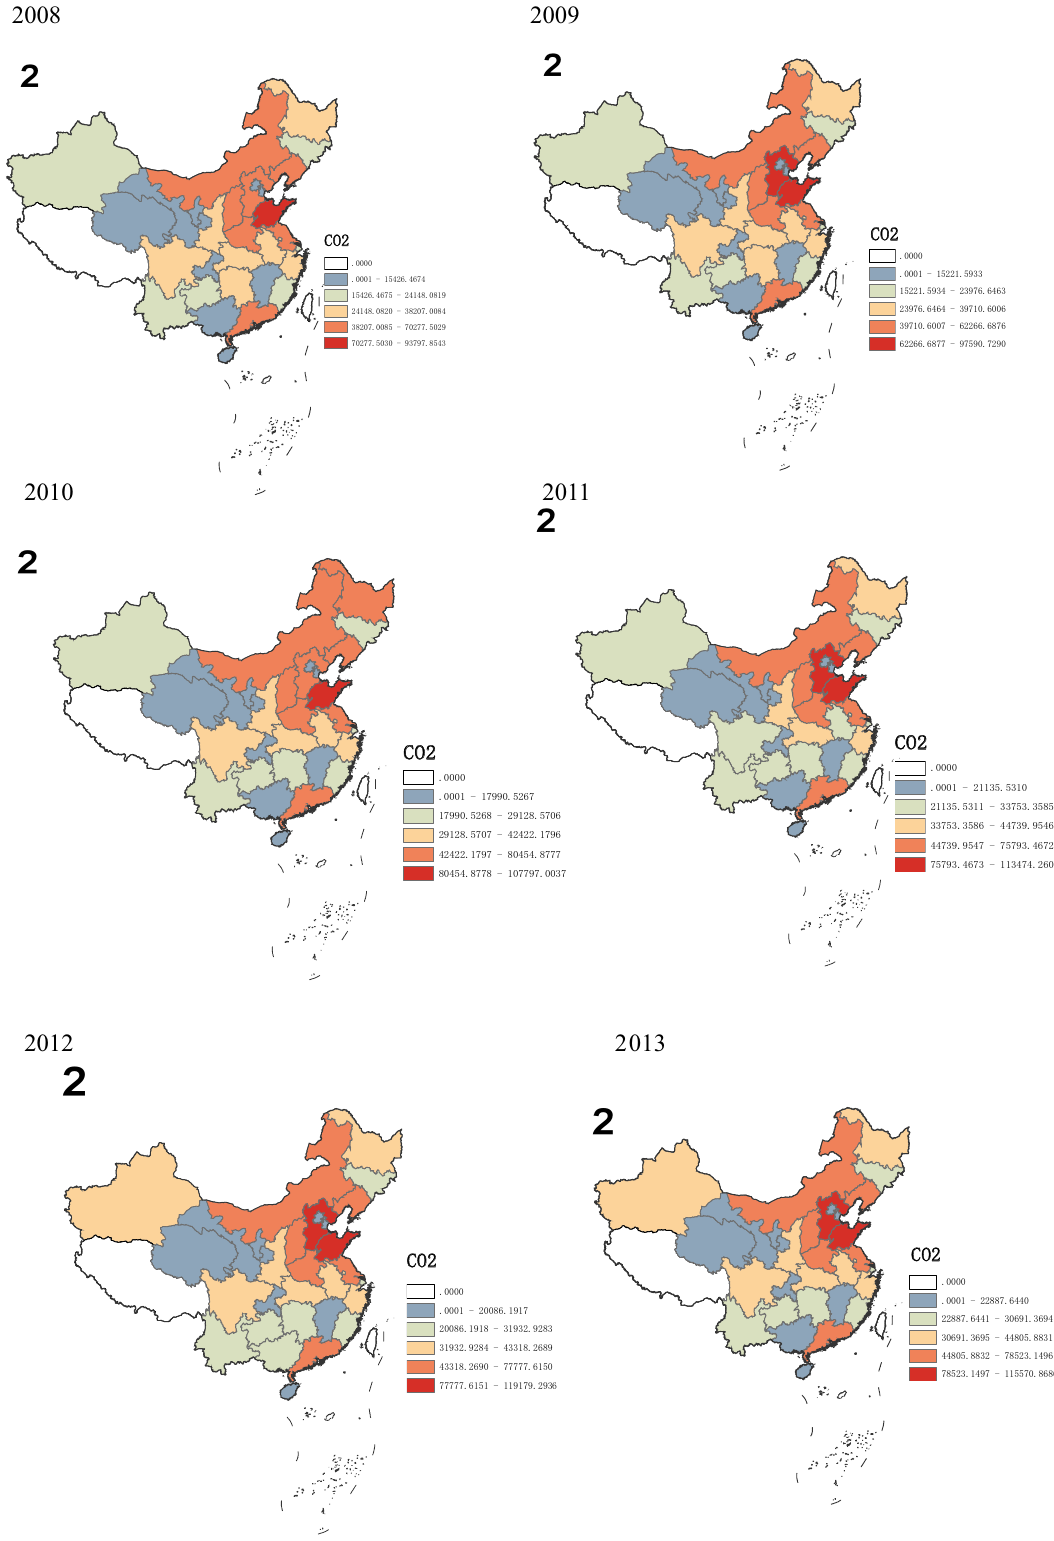
Figure 3. Spatial pattern of China’s emissions. Source : ArcMap10.7 https:// deskt op. arcgis. com/ zh- cn/